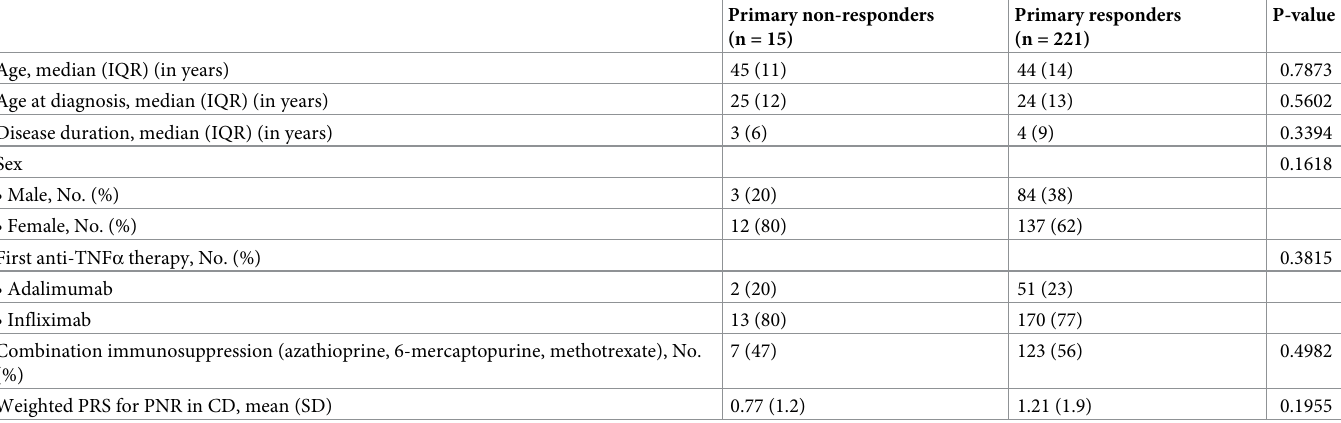
Primary non-responders Primary responders P-value (n = 15) (n = 221)